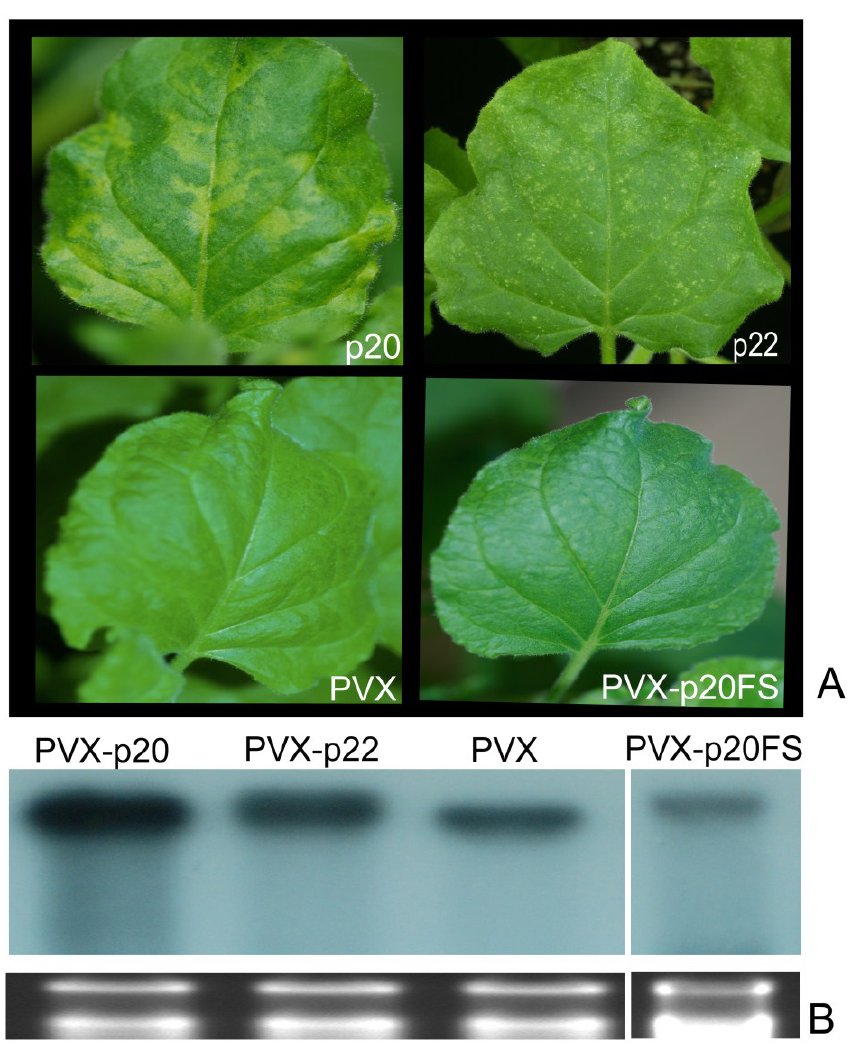
Figure 8. Effects of PMWaV-2 proteins on PVX pathogenicity. ( A ) Symptoms in systemic leaves of plants inoculated with PVX alone or with PVX containing PMWaV-2 ORFs p20, p22, or a frameshift mutant (FS) of PMWaV-2 p20. ( B ) Northern blot analysis with digoxigenin-labeled PVX coat protein RNAs of total RNAs isolated at 5 weeks post inoculation from upper uninoculated leaves of PVX-infected plants or plants infected with PVX containing PMWaV-2 p20, p22 ORFs, or a frame shift mutant (FS) of PMWaV-2 p20. Ethidium bromide staining of ribosomal RNA was used to confirm equal loading of RNAs. Northern analysis of the RNA levels of PVX-PMWaV-2-p20 and PVX-PMWaV-2-p22 in symptomatic infected leaves was used to compare the RNA levels in leaves of PVX or PVX-PMWaV-2-p20 (FS) infected leaves. The incorporation of PMWaV-2-p20 and PMWaV-2-p22 into the PVX genome apparently enabled PVX to accumulate to higher levels in systemic leaves infected with the PVX-PMWaV-2-p20 or PVX-PMWaV-2-p22 constructs (Figure